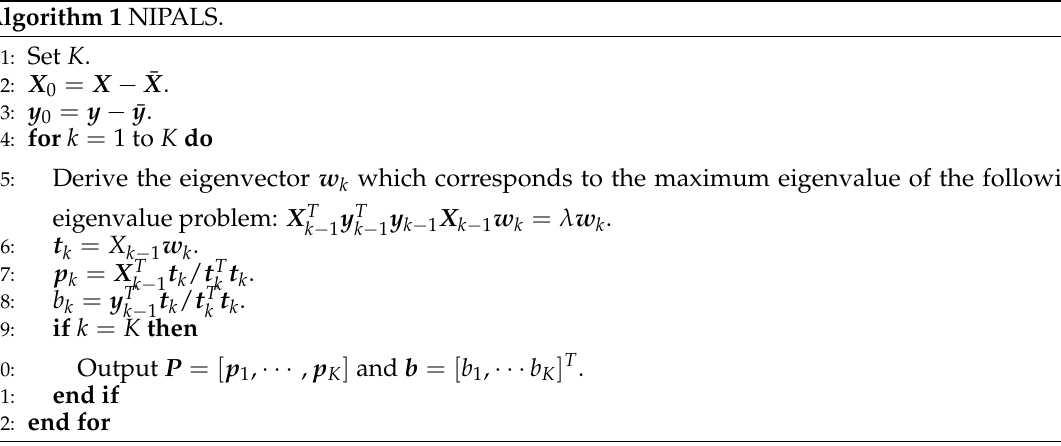
Algorithm 1 describes the eigenvalue-based NIPALS algorithm for PLS modeling. Algorithm 1